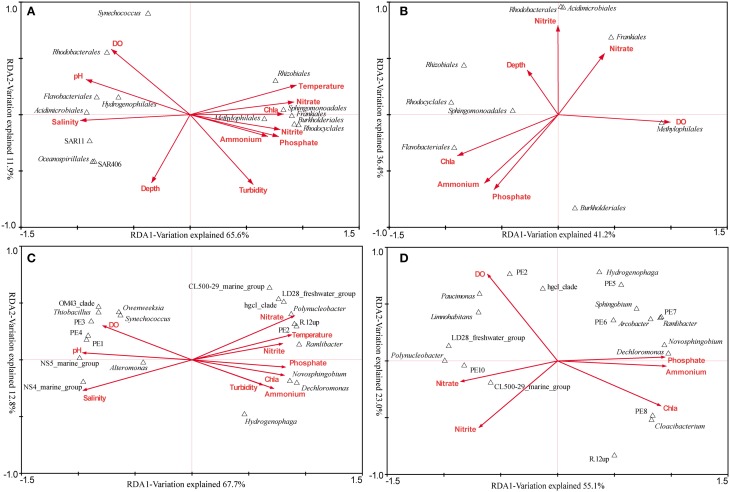
The relationship between major bacterial taxa (taxonomy of sequences) and environmental factors. (A) RDA across all samples at the order level. (B) RDA targeting only freshwater samples at the order level. (C) RDA across all samples at the genus level (the top 20). (D) RDA targeting only freshwater samples at the genus level (the top 20). In the RDA targeting freshwater sites, seven environmental factors were analyzed as the others were essentially the same.